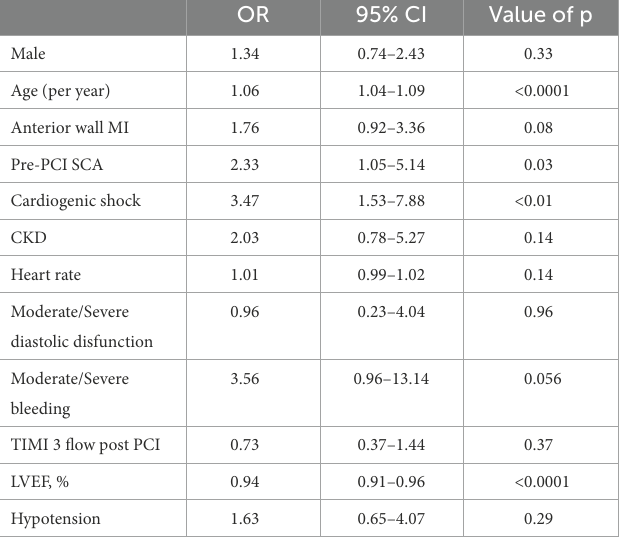
TABLE 2 Variables associated in-hospital mortality in multivariate